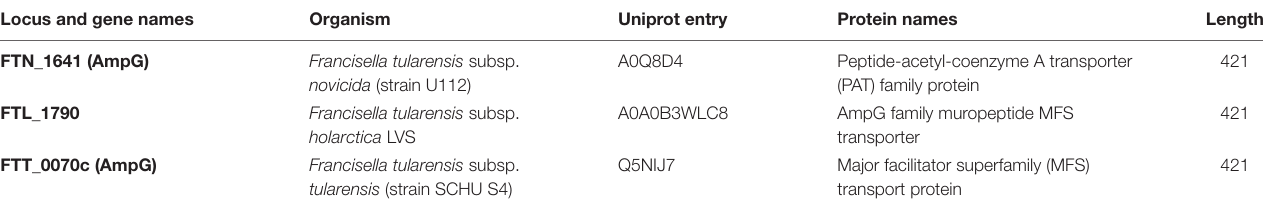
TABLE 3 | Putative AmpG permease homologs (MFS protein) in Francisella (selected genes from Uniprot.org). Locus and gene names